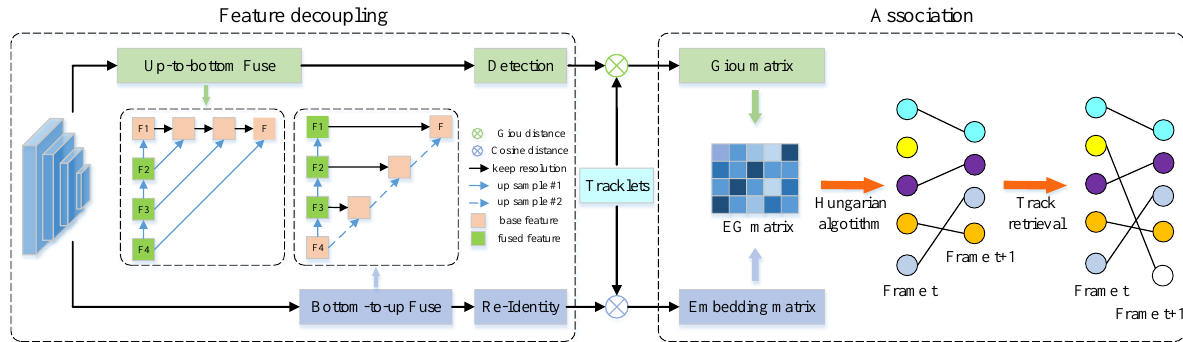
Figure 3. The overall pipeline of SimpleTrack. The input image is first fed to a backbone network to extract high-resolution feature maps. Then, we use different feature fusion methods for detection and re-identity separately, and combine the embedding and GioU distance matrix as the similarity matrix. At the end of the association phase, the tracking retrieval mechanism is used to recover the undetected